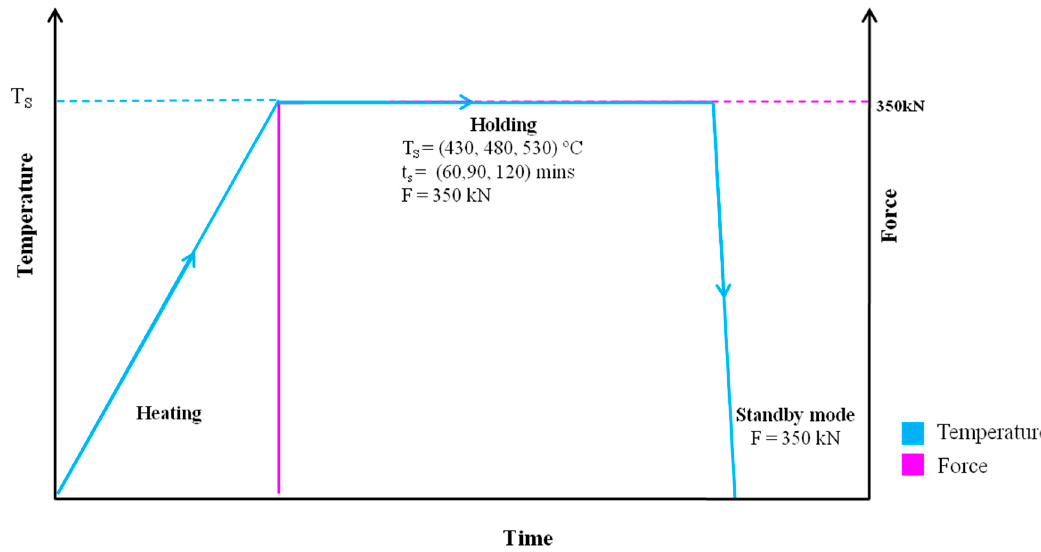
Figure 1. Hot press forging diagram.